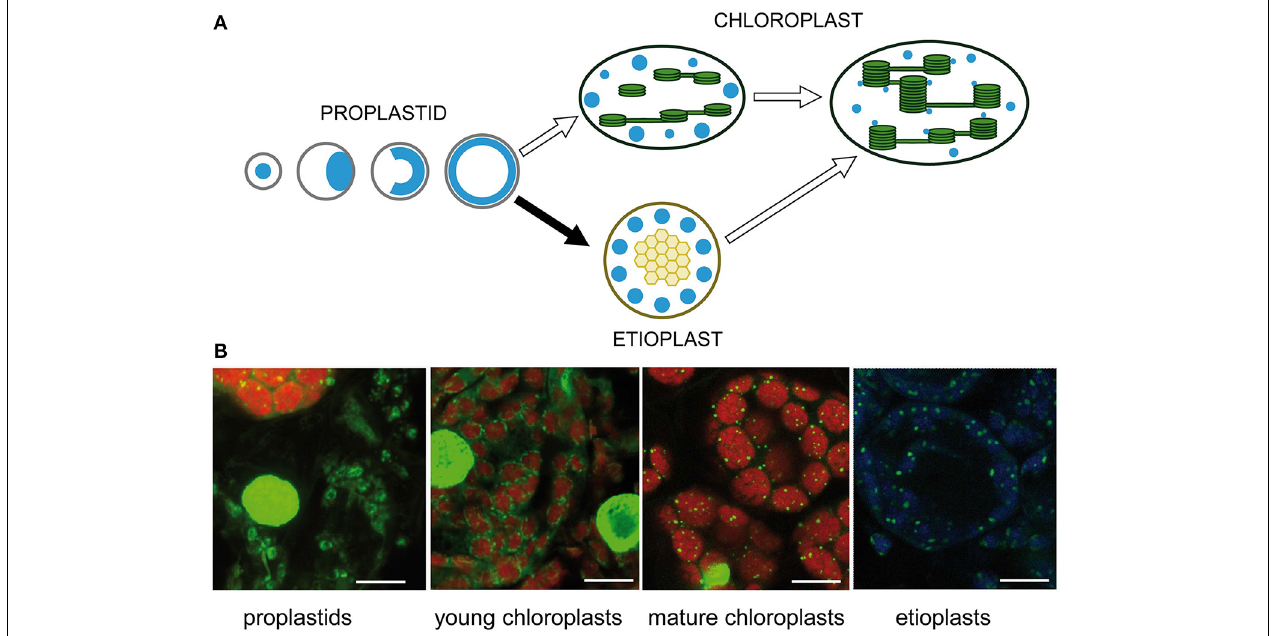
FIGURE 3 | Nucleoid organization during chloroplast development. (A) Schematic drawing adapted from Sakai et al. (2004). (B) Detection of nucleoids by fluorescence microscopy of barley leaf sections stained with SYBR Green. The left image shows undifferentiated rudimentary plastids in white parts of a striped leaf of the mutant albostrians